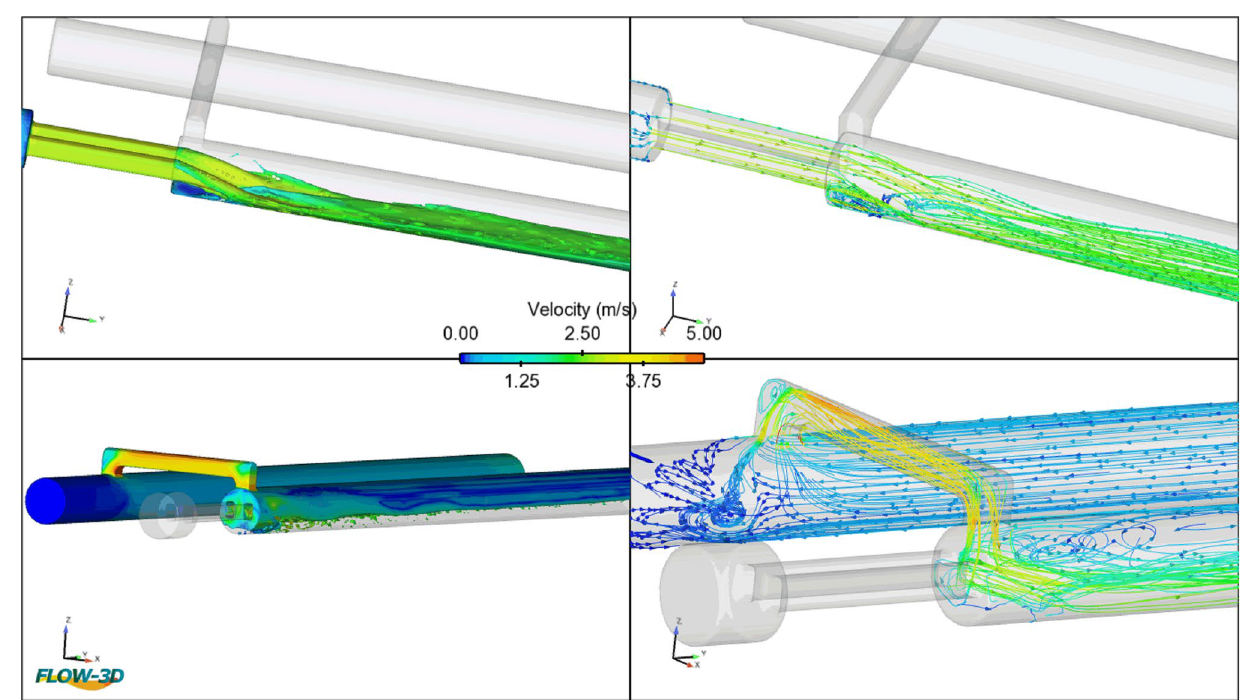
Fig. 4 Views from CFD analysis of the Ilısu outlet and